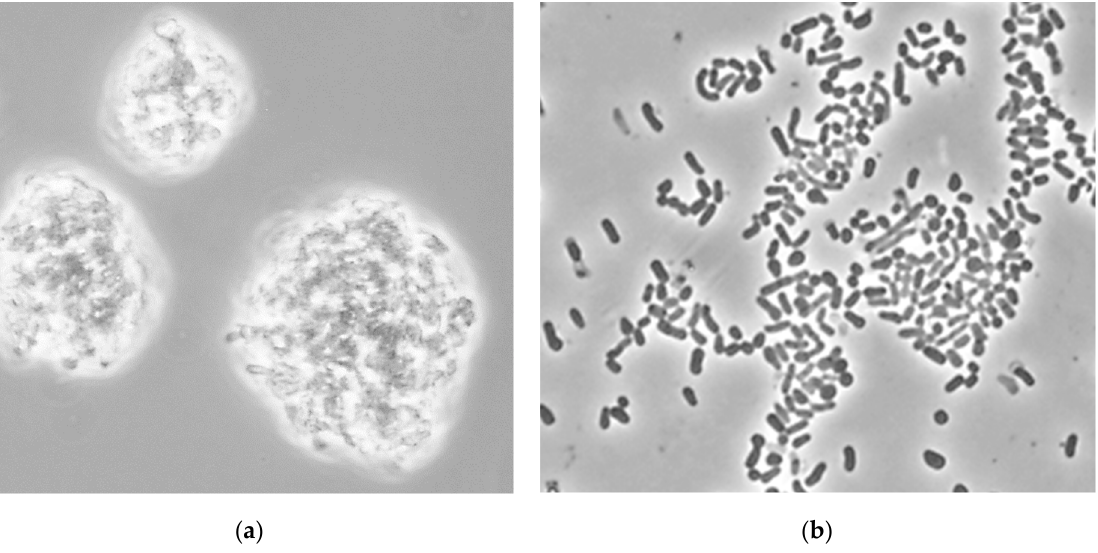
Figure 2. Phase-contrast microscopy of cells of R. erythropolis IEGM 766 ( a ) and R. ruber IEGM 1135 ( b ) exposed to HAuCl 4 (magnification ×1000).